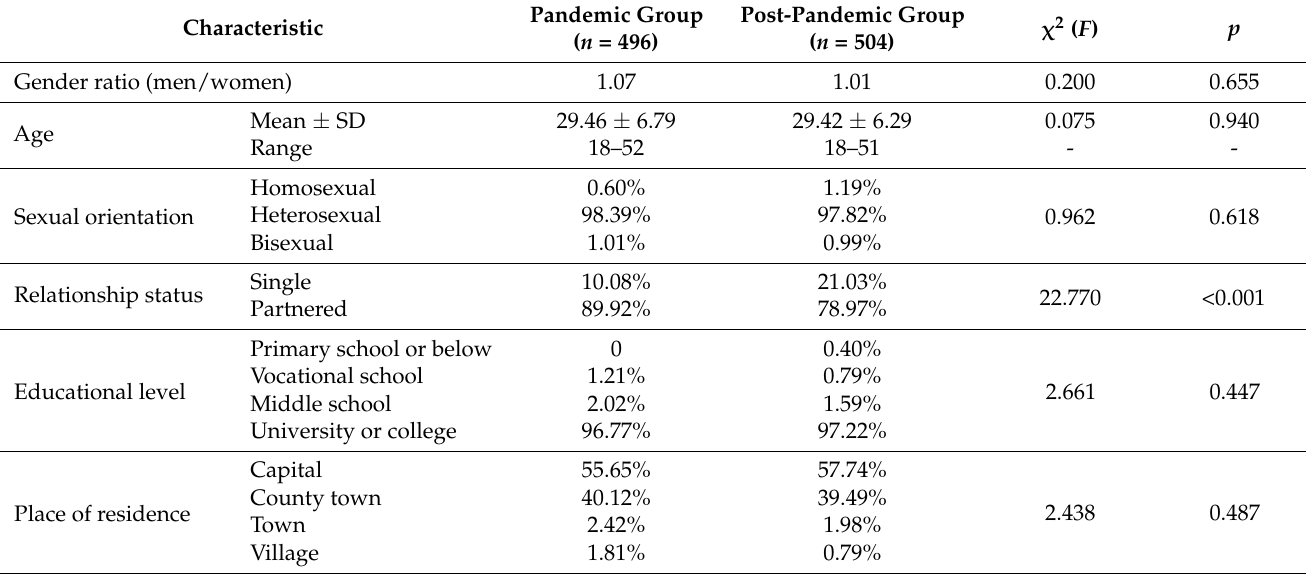
Table 1. Comparisons of the two groups on demographic